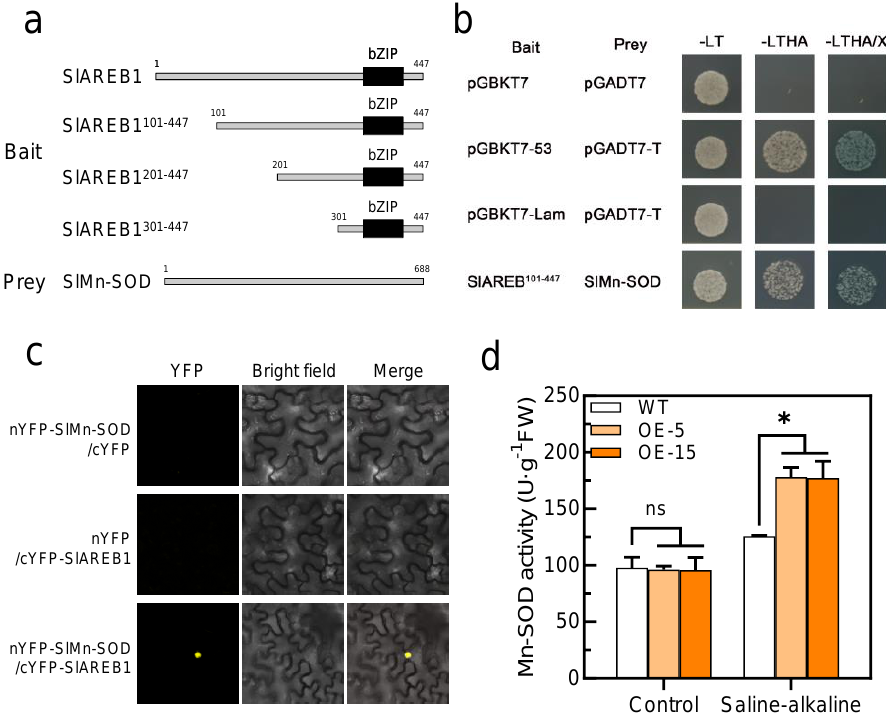
Figure 7. SlAREB1 directly interacts with SlMn-SOD. ( a ) Schematic diagram of the SlAREB1-truncated fragments used to construct the bait vectors. Amino acid positions of fragments were numbered. ( b ) SlAREB1 interaction with SlMn-SOD as determined in yeast two-hybrid assays. ( c ) SlAREB1 interaction with SlMn-SOD in vivo as determined by bimolecular fluorescence complementation (BiFC) assay. Yellow mark indicates fluorescence signals. ( d ) Mn-SOD activity in WT and transgenic tomatoes under saline–alkaline stress for 7 d. Distilled water was used as control. Values represent averages of four independent measurements, and error bars represent standard errors. Asterisks denote a significant difference compared with the control (* p < 0.05).